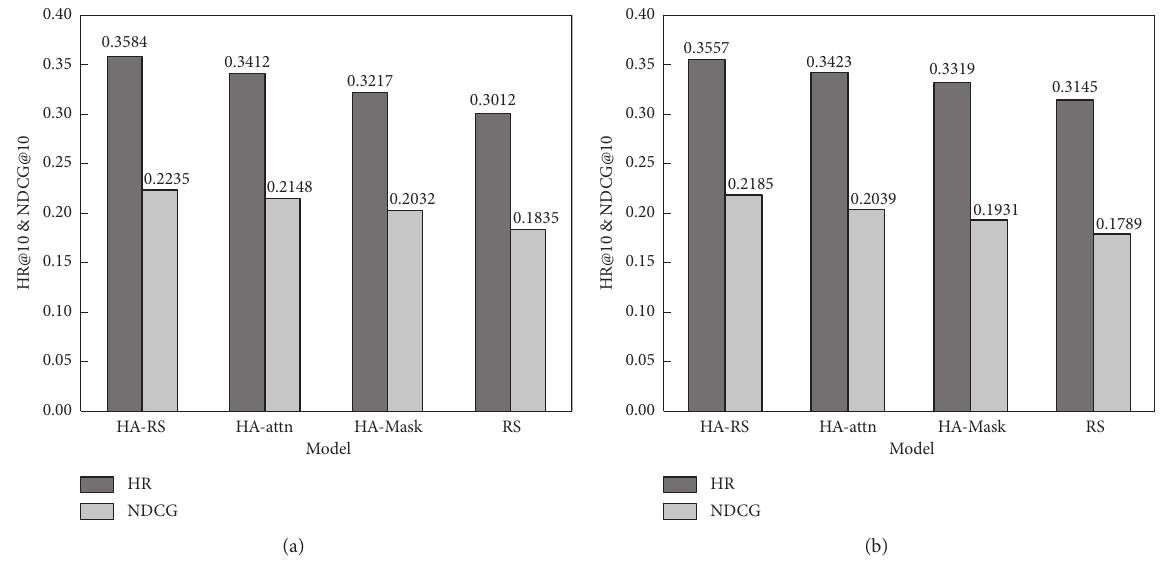
Figure 3: The results of the ablation experiment. (a) HR@10 and NDCG@10 comparisons for dimension size � 64. (b) HR@10 and NDCG@10 comparisons for the top-10 values.